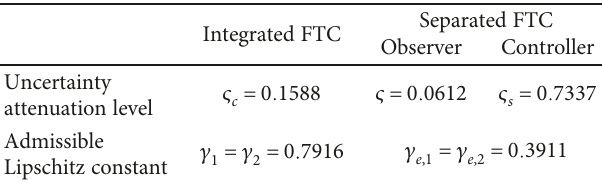
Figure 3: Schematicdiagramofasingle-link fl exible-jointrobotarm. Table 2: LMI optimization